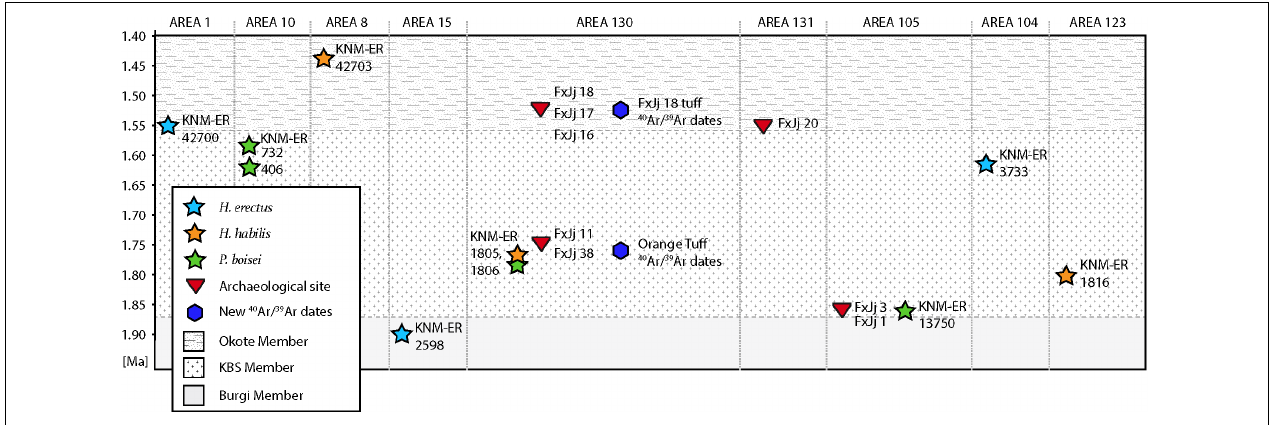
FIGURE 6 | Chronostratigraphic chart showing the position of sites from Area 130 (this study) and their correlations with selected fossils and archeological sites elsewhere in the Koobi Fora Formation. See Figure 1 for geographic location of areas listed at the top of the figure. Age for the KBS Tuff and for the KBS-Okote boundary from McDougall and Brown